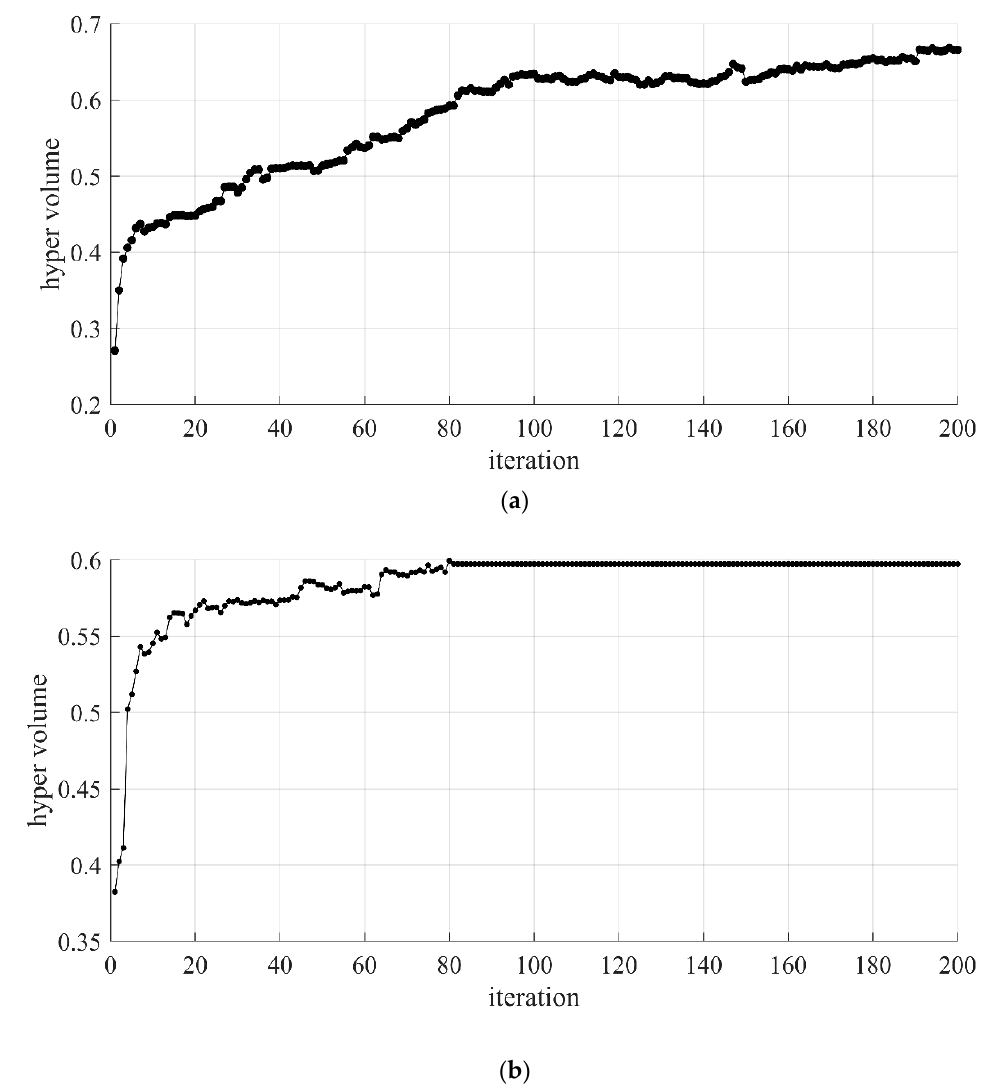
Figure 8. Hypervolume history for the convergence rate of the optimizers in ( a ) Case. I. and ( b ) Case. II.